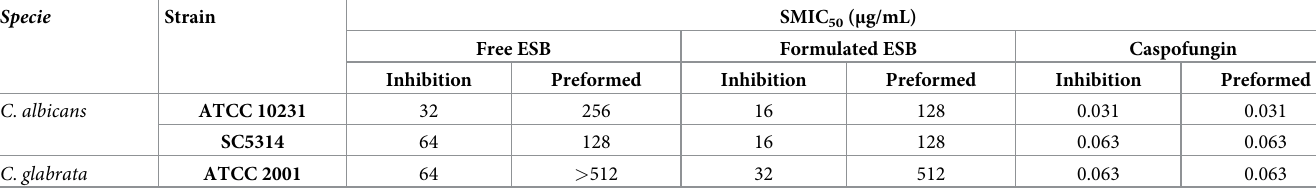
Table 3. Effect of free or formulated ESB on biofilms of C albicans and C . glabrata strains. Specie